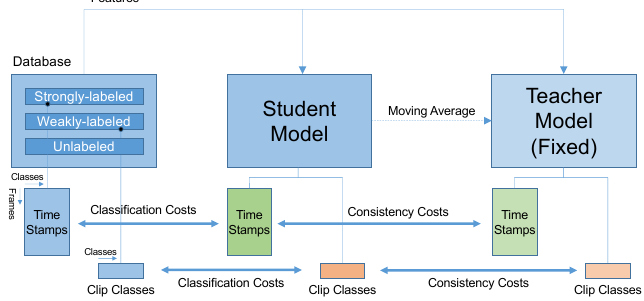
Figure 5. Block diagram of the mean-teacher